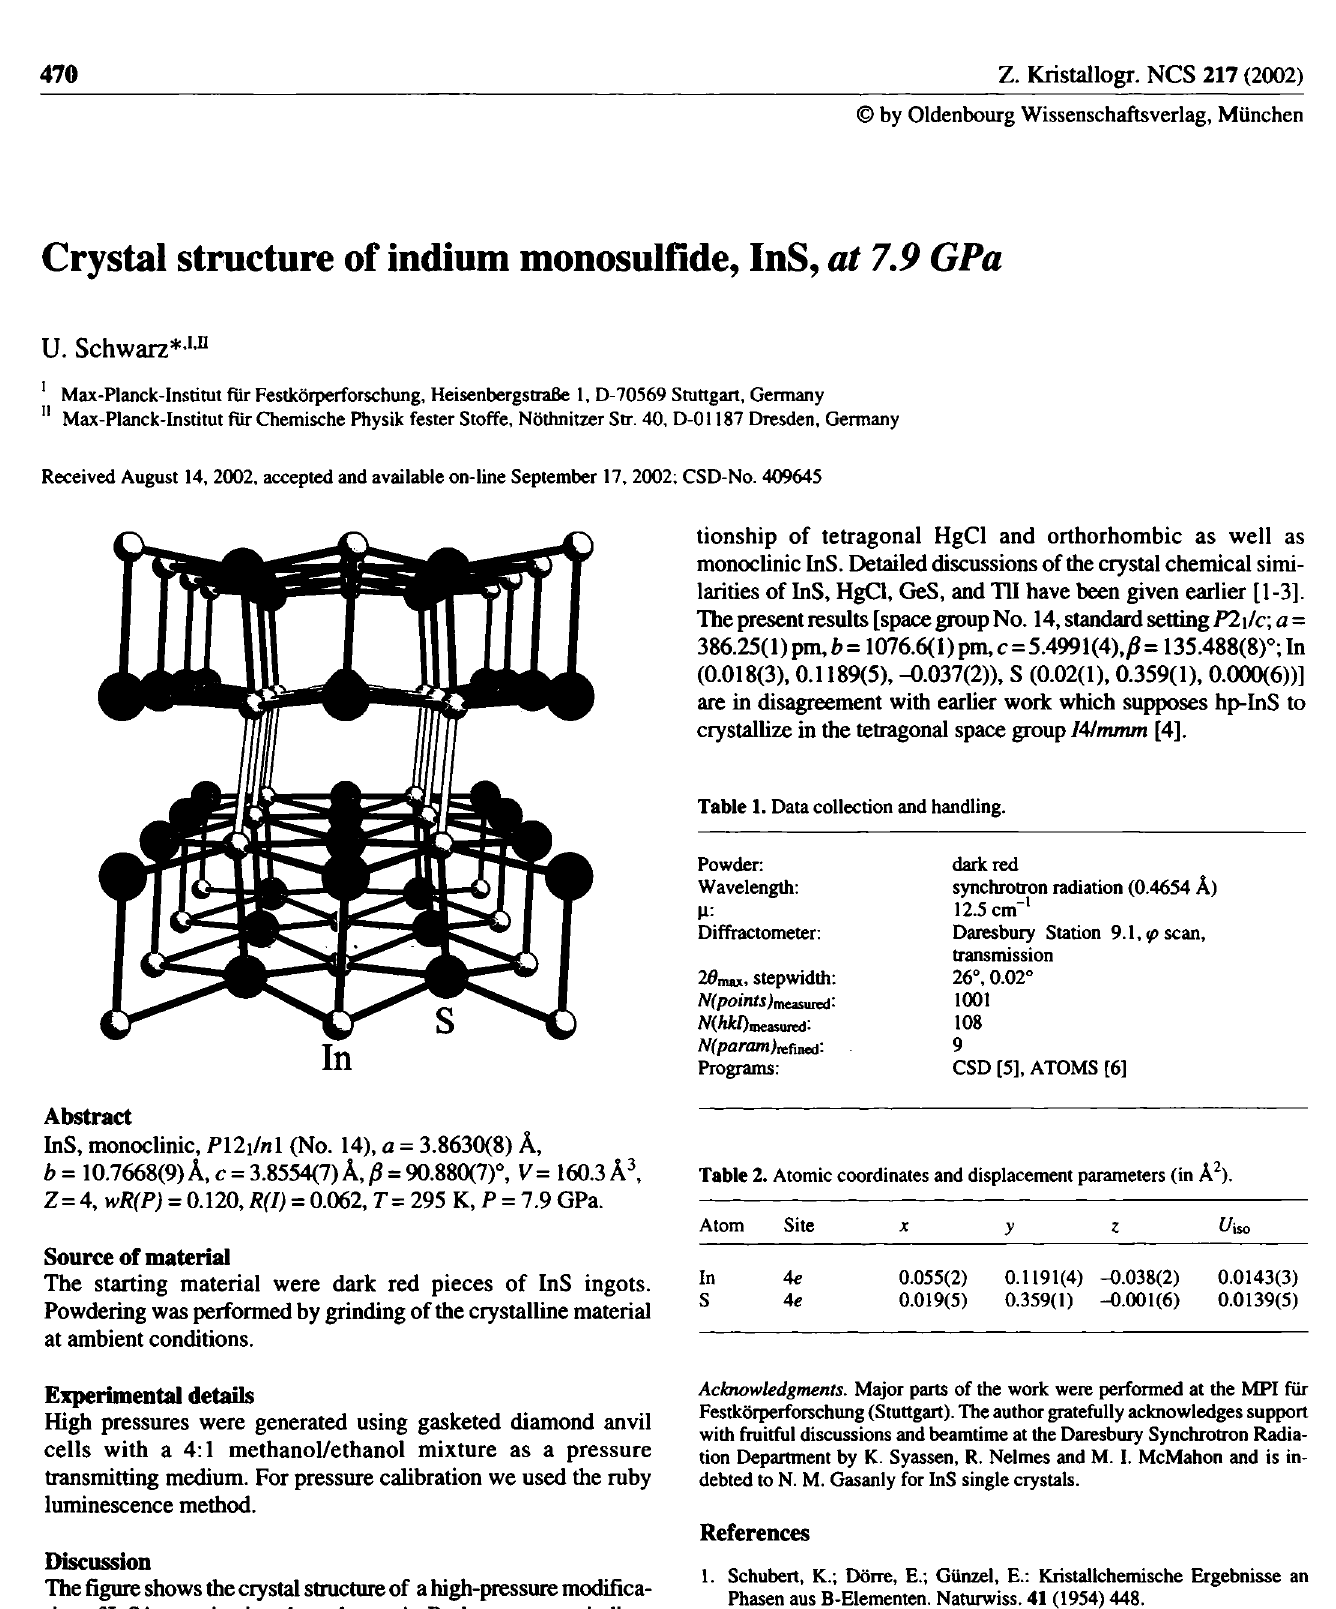
Table 2. Atomic coordinates and displacement parameters (in Â 2